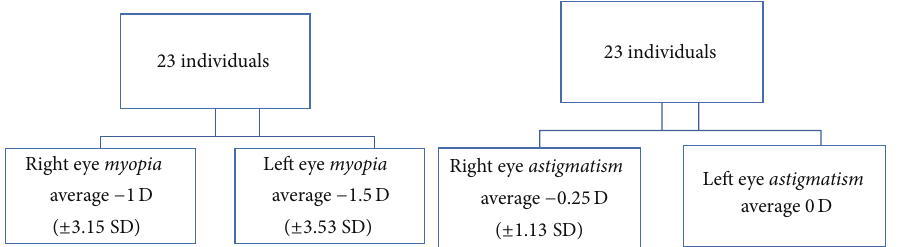
Figure 2: Evaluation of refractive errors. The data showed refractive errors (mild myopia and low astigmatism) not able to alter binocular vision and therefore the ocular motility of the examined